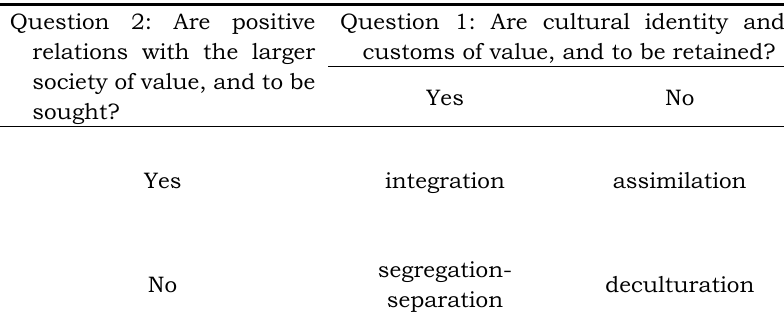
segregation- separation